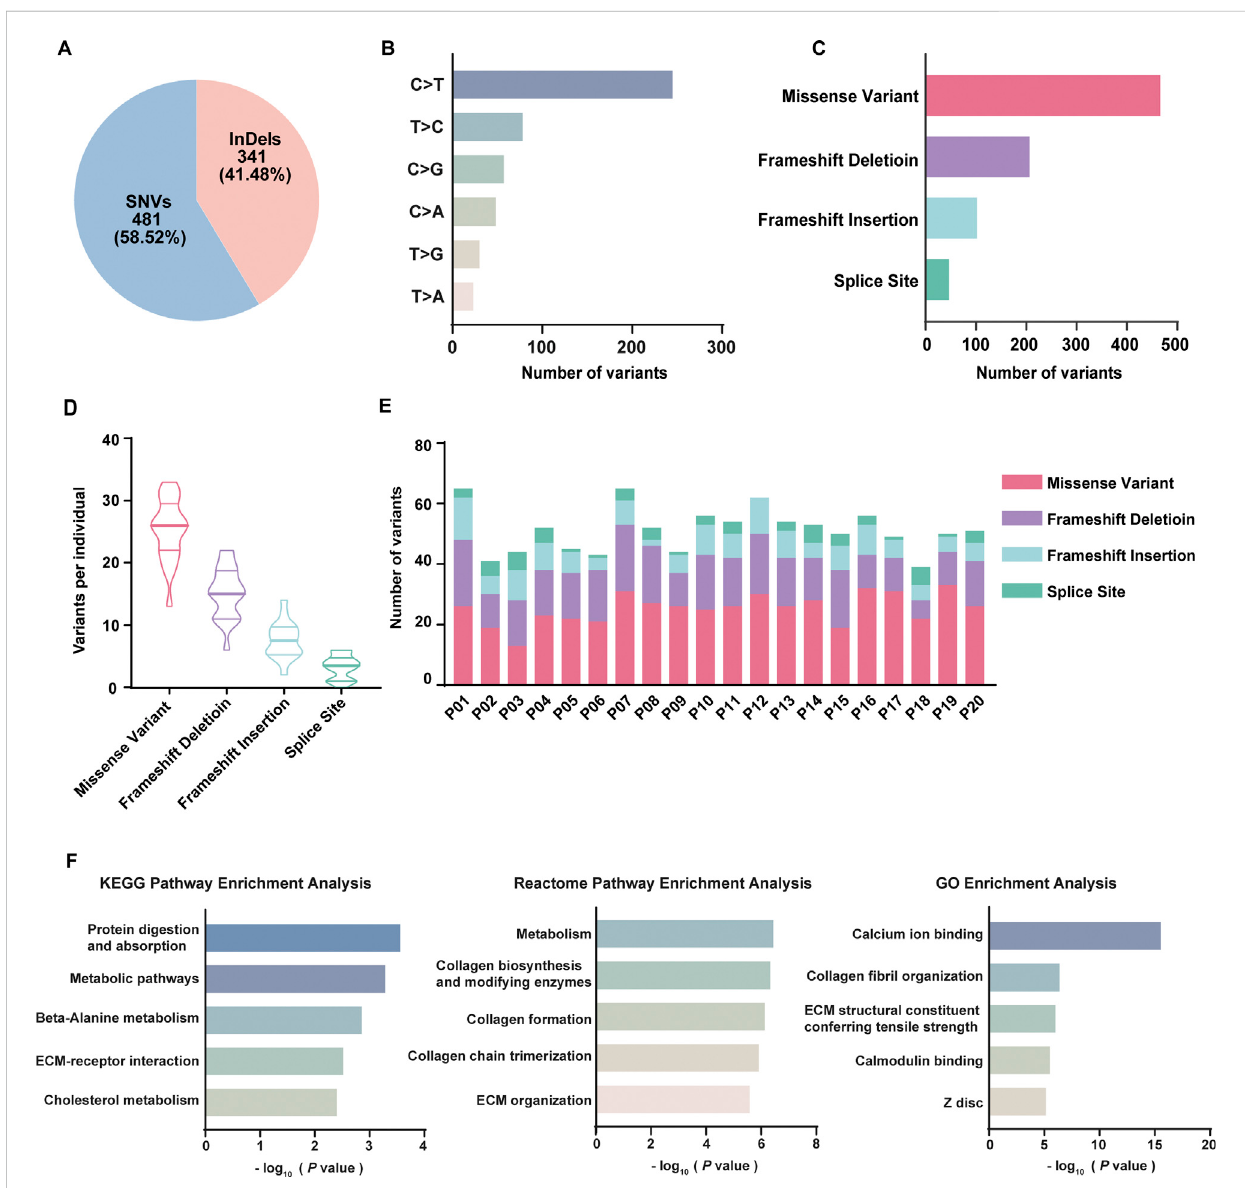
FIGURE 2 Summary of whole exome sequencing results of 20 DOR patients. (A) The percentage of SNVs and indels in fi ltered variants; (B) The classes of SNVs and their frequencies; (C) The frequencies of different types of variants in total samples; (D) The violin plot of the number of different types of variants in each patient; (E) The distribution of different types of variants in each patient; (F) Functional analysis of 731 genes using KEGG, Reactome, and GO